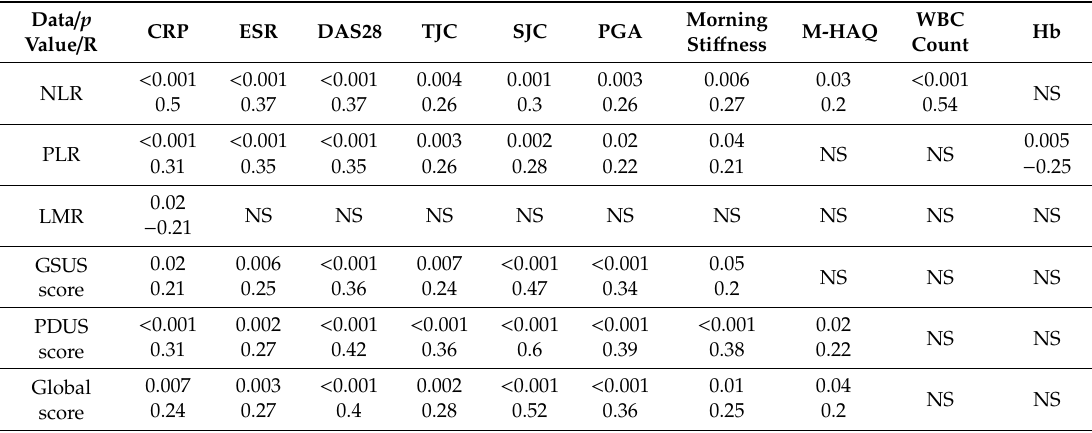
Table 2. Statistical results (R Spearman) of associations between different disease activity parameters and inflammatory markers in RA patients.